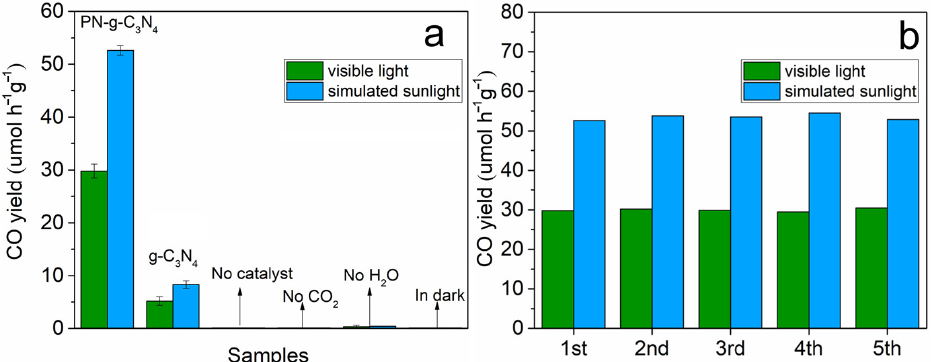
Figure 7. ( a ) Photocatalytic activity of CO 2 reduction of g-C 3 N 4 and PN-g-C 3 N 4 samples under visible light illumination and simulated sunlight with controls. ( b ) Photocatalytic cycle test of PN-g-C 3 N 4 . As presented in Figure 7b, the yield of CO is stable without any significant deactivation after five cycles (15 h illumination), which indicates high photostability of PN-g-C 3 N 4